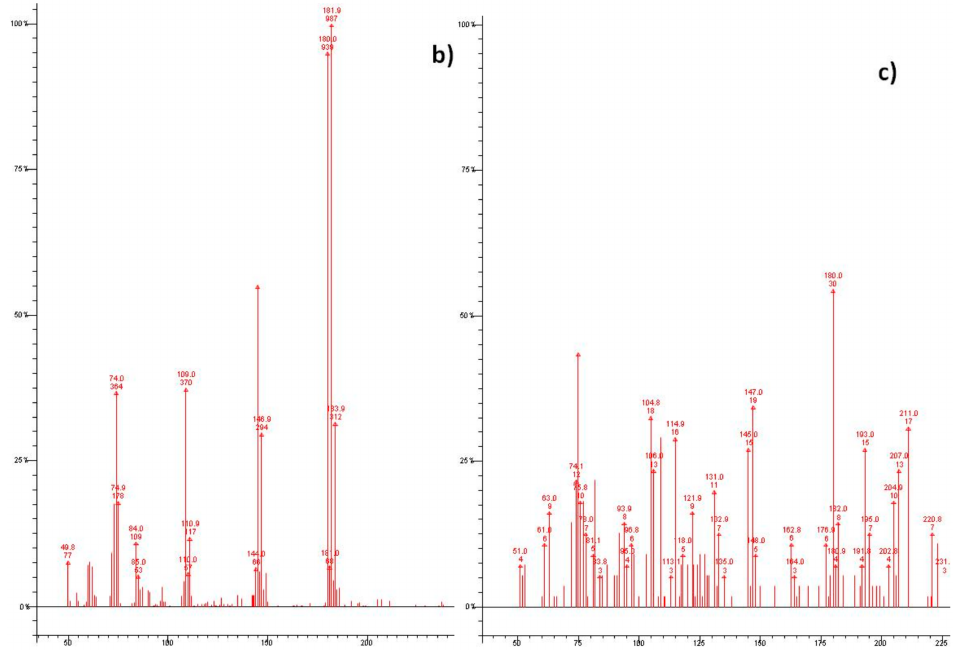
Figure 8. Mass spectra of the solutions obtained after photocatalytic treatment of TCB using MTi1 catalyst for 5 min ( a ) and MTi2 for 5 ( b ) or 15 ( c ) minutes.